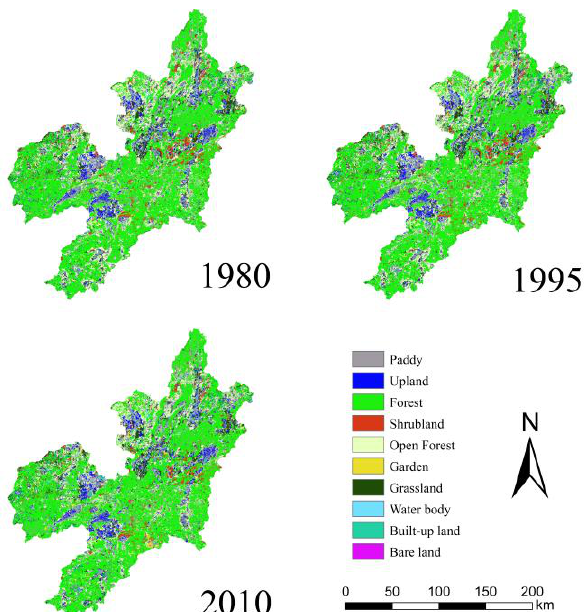
Figure 2. Land-use distribution in the upper Ganjiang Basin, 1980, 1995, and 2010. The sequential uncertainty fitting (SUFI-2) method in the SWAT Calibration and Un- certainty Program (CUP) was used for model calibration and validation using the P-factor and R-factor to measure the effects of model rate-setting and uncertainty analysis [30,34]. The P-factor represents the percentage of observed data enveloped by the modeling result, the 95 PPU (95% prediction uncertainty), and the R-factor represents the mean width of the 95 PPU interval divided by the standard deviation of the measured data. In general, the closer the P-factor is to 1 and the closer the R-factor is to 0, the closer the simulation is to the true value. The uncertainty of the simulation is considered acceptable when the P-factor > 0.5 and R-factor < 1.5; when the P-factor > 0.7 and R-factor < 1, the uncertainty of the simulation is low [30]. The coefficient of determination (R 2 ) and the Nash–Sutcliffe coefficient (NS) were used in this paper to evaluate the applicability of the SWAT model. R 2 indicates the consistency of the trends between the simulated and measured values. A value closer to 1 means that the simulated values are more consistent with the measured values. R 2 > 0.6 is usually used as a criterion for the degree of correlation between measured and simulated values. NS indicates the degree of the deviation of the measured value from the simulated value. The closer the value is to 1, the smaller the deviation between the simulated and measured values. When NS ≤ 0.36, the simulation is considered to be unsatisfactory. When 0.36 < NS < 0.75, the simulation is considered to be good. When NS ≥ 0.75, the simulation is considered to be excellent